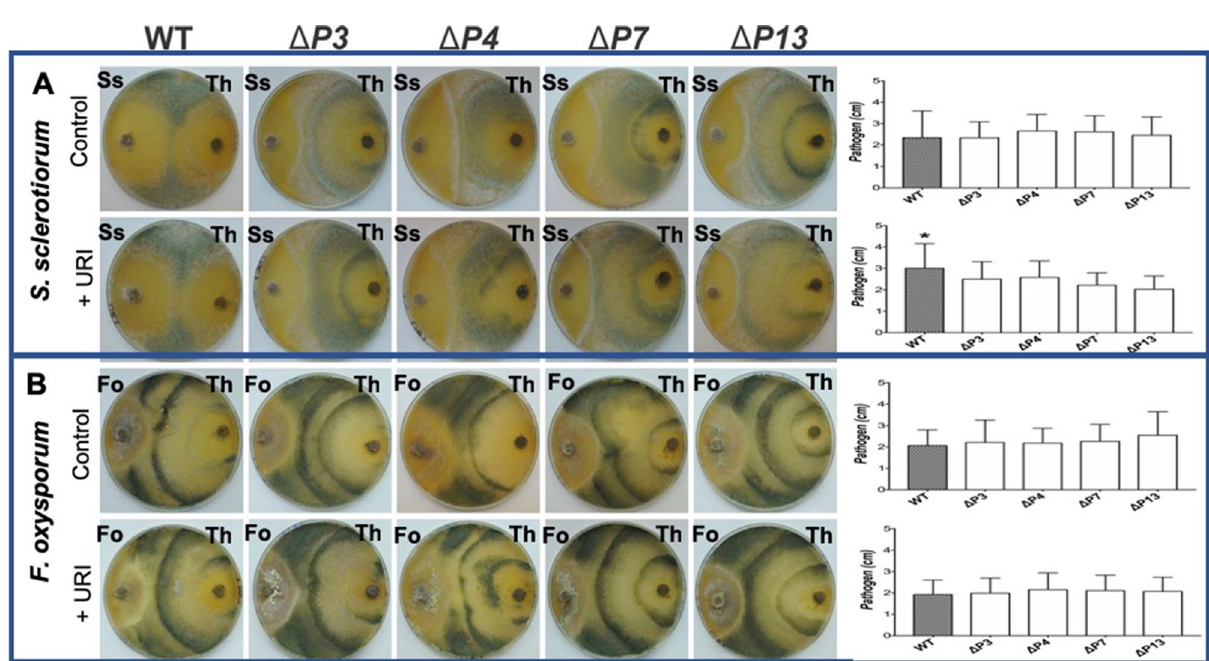
Figure 3. Mycoparasitic abilities of uridine auxotrophic mutants. The antagonistic activity of mutants ( ΔP3 , ΔP4 , ΔP7 , and ΔP13 ) in comparison to the T. harzianum wild-type was assessed in plate confrontation assays using Sclerotinia sclerotiorum ( A ) or Fusarium oxysporum ( B ) as host fungus. Bioassays were conducted in presence and absence of uridine. *Bars marked with asterisk differ significantly ( P <